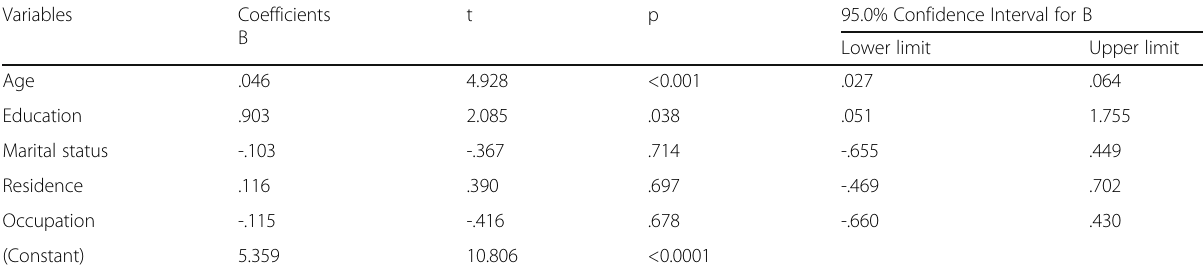
Table 6 Linear regression model showing effect of some socio-demographic factors on participants ’ knowledge Variables